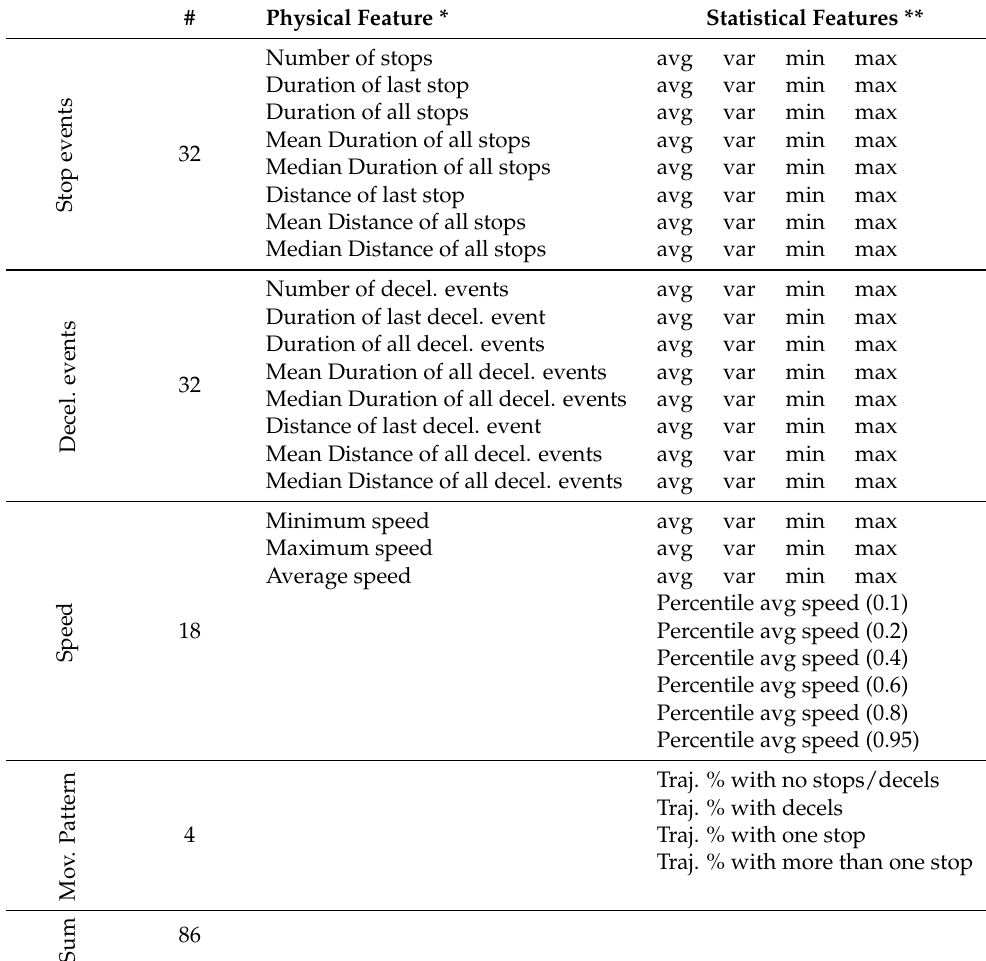
Table 2. Overview of the features derived from the dynamic model. #